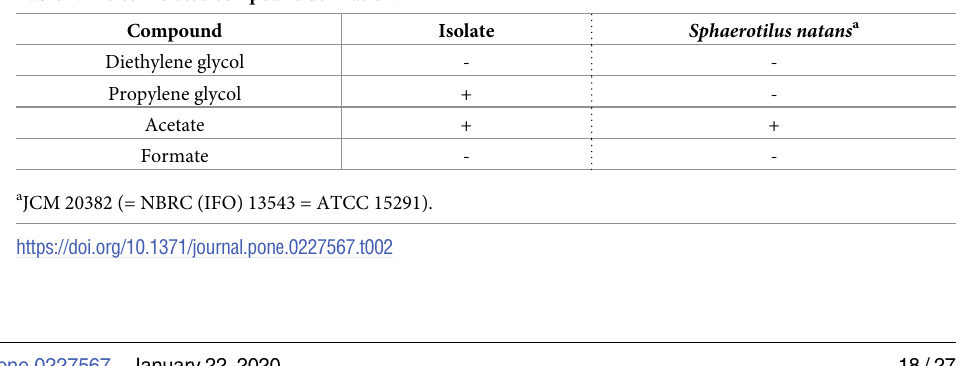
Maltose Fructose Glycerol Ethanol Glutamate Proline + + a Commonly utilized by known Sphaerotilus strains. b Data from Gridneva et al., 2011 [62]. c Poor growth.